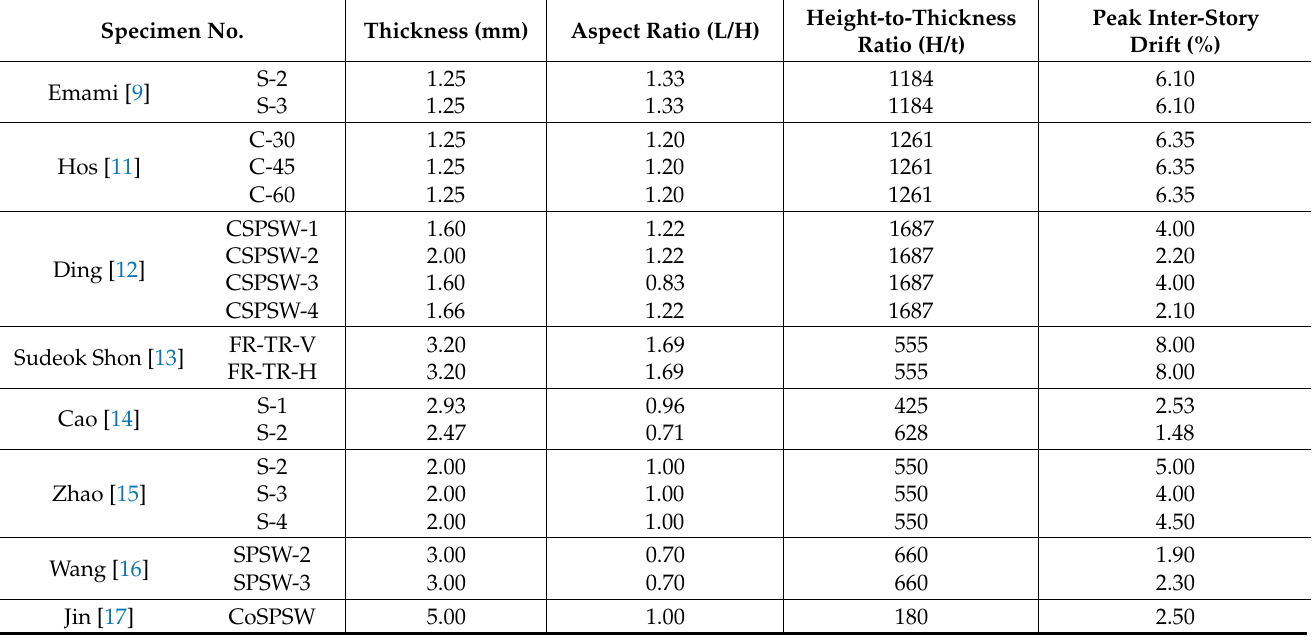
Table 1. Test data of 19 corrugated steel plate shear wall specimens.